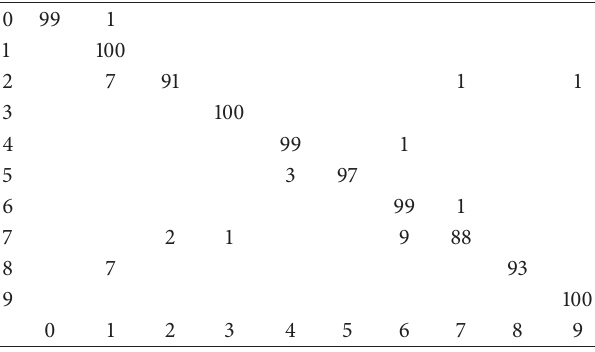
Table 3: The confusion matrix of our method on data set 2.